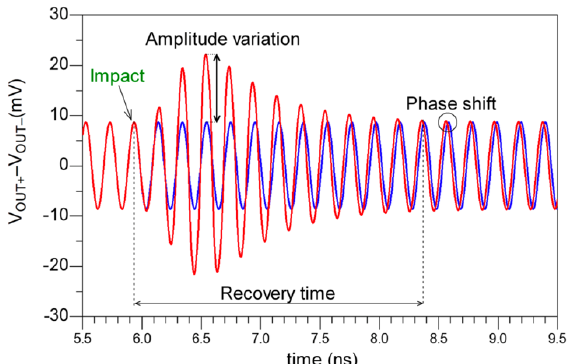
Figure 5. The blue signal is the output without an impact on any transistor and the red signal is the signal when there is an impact on a transistor.